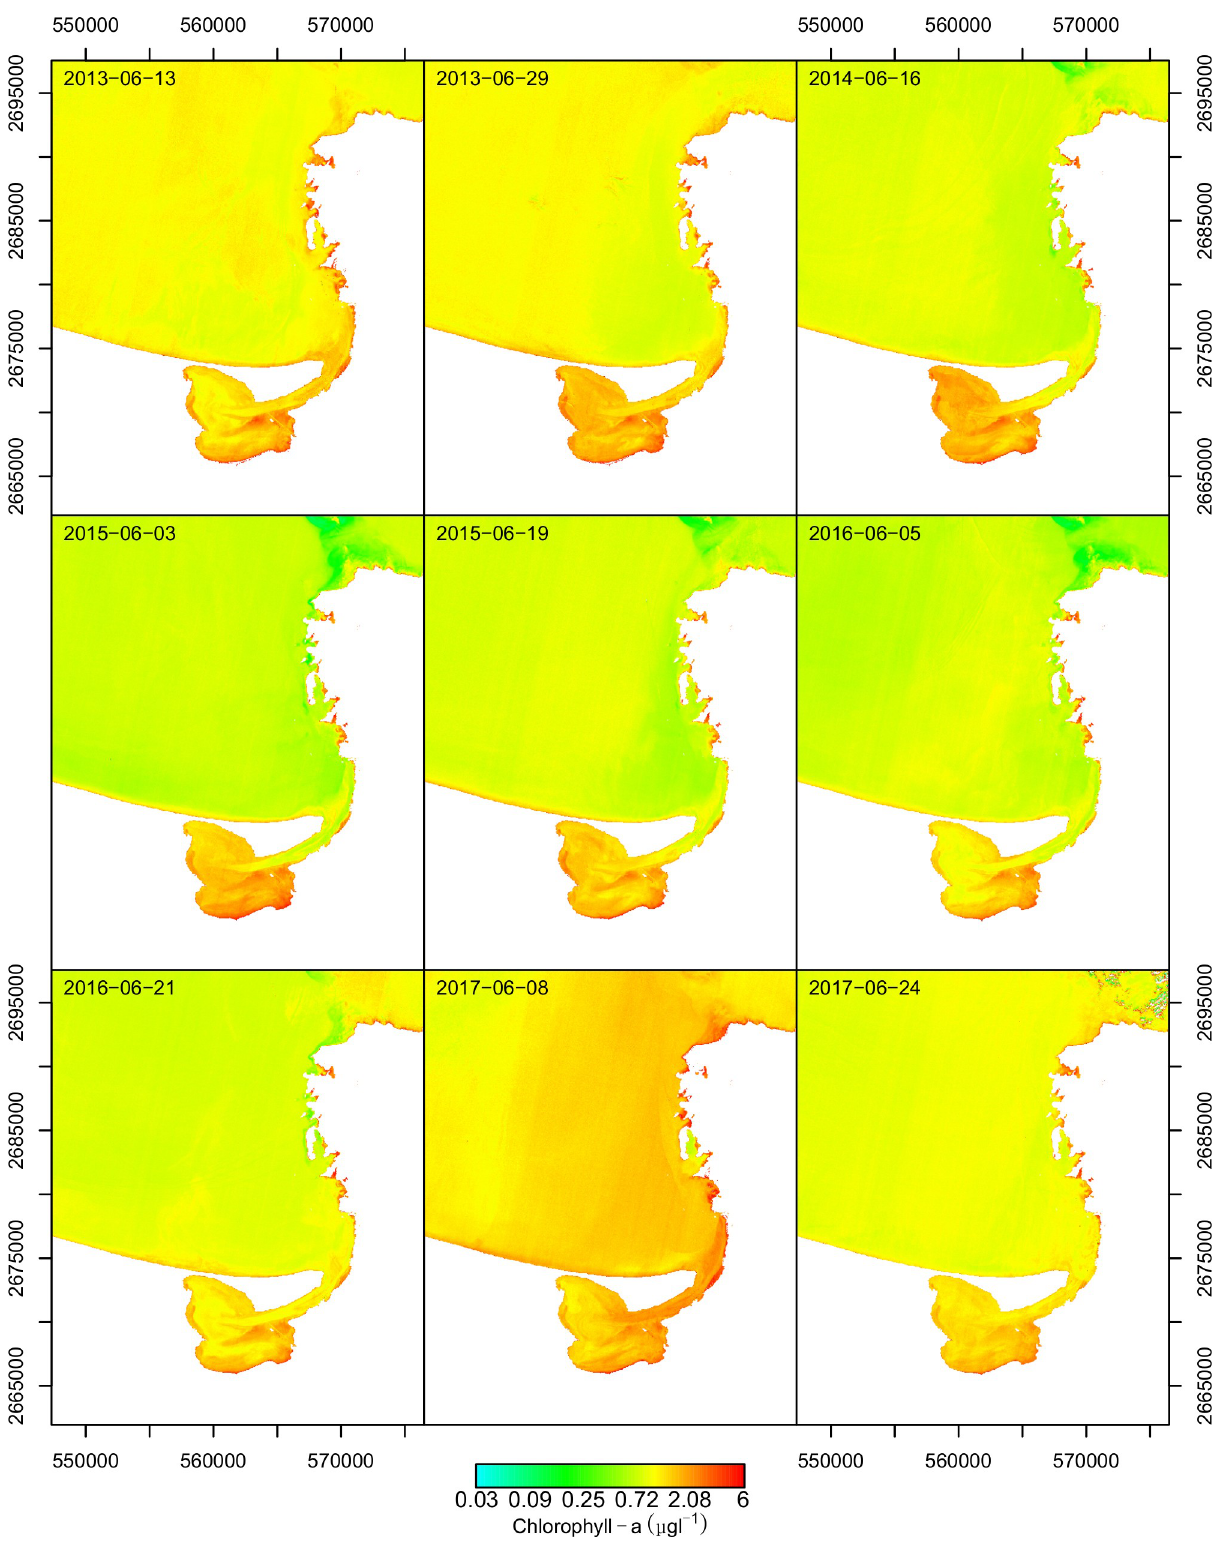
Fig 5. Predicted Chlorophyll-a ( μ g � l -1 ) in the study area, corresponding to June 2013 to 2017. Maps generated in programming language R.